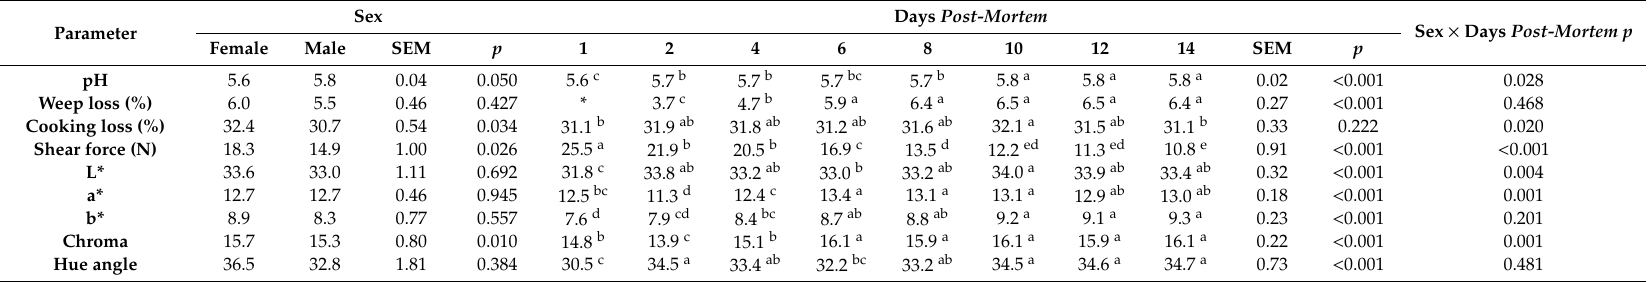
Table 1. E ff ect of sex and ageing period (days post-mortem ) on the physical parameters of impala longissimus thoracis et lumborum meat. Significant interactions were found for pH, cooking loss, shear force, L*, a*, and chroma values, and thus main e ff ects are not interpreted but depicted within the table only. Sex Days Post-Mortem Parameter